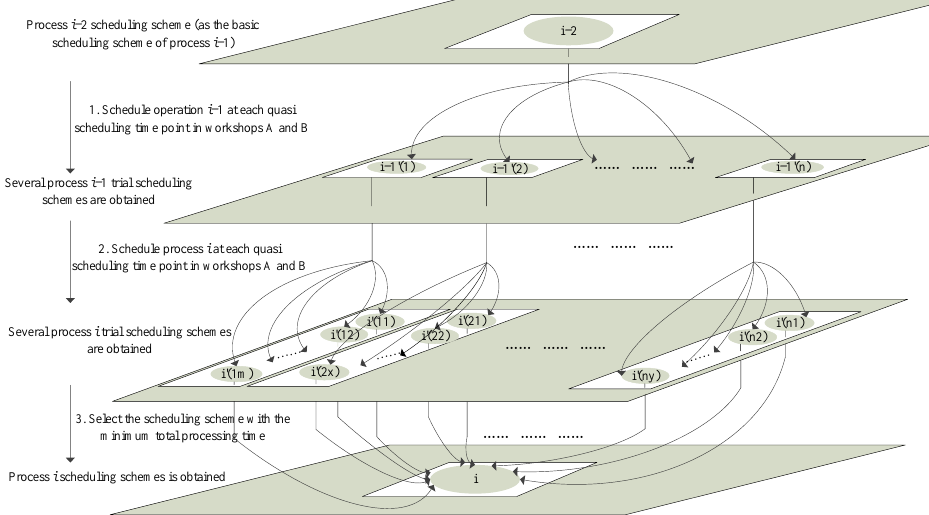
Figure 6. Gantt chart of scheduling results of the algorithm in this paper.